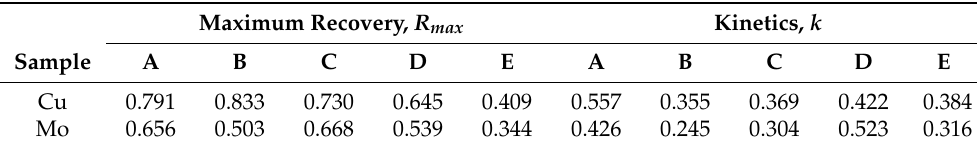
Table 7. Maximum recovery ( R max ) and flotation kinetics coefficient ( k ) of copper and molybdenum in each ore